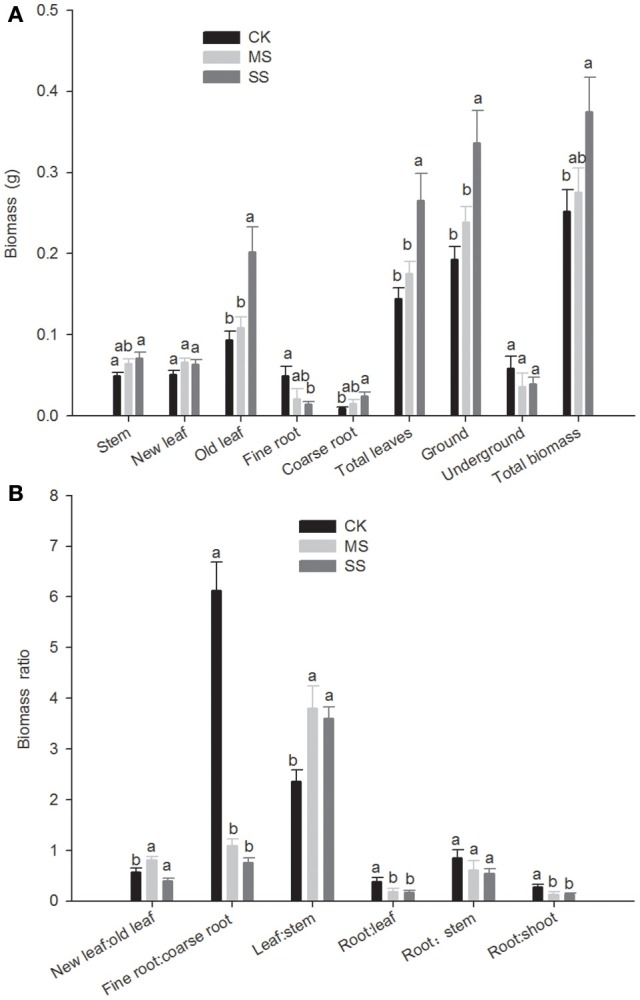
The biomass and ratio of different parts under different water conditions Bothriochloa ischaemum biomass (A) the biomass of different parts, (B) the biomass ratios of different parts. CK (adequate moisture), black bars with white crosshatching; MS (moderate water stress), white with black diagonal lines; SS, (severe water stress), white with black dots. Lowercase letters above each bar indicate significant difference (P < 0.05); vertical lines, mean ± SE.